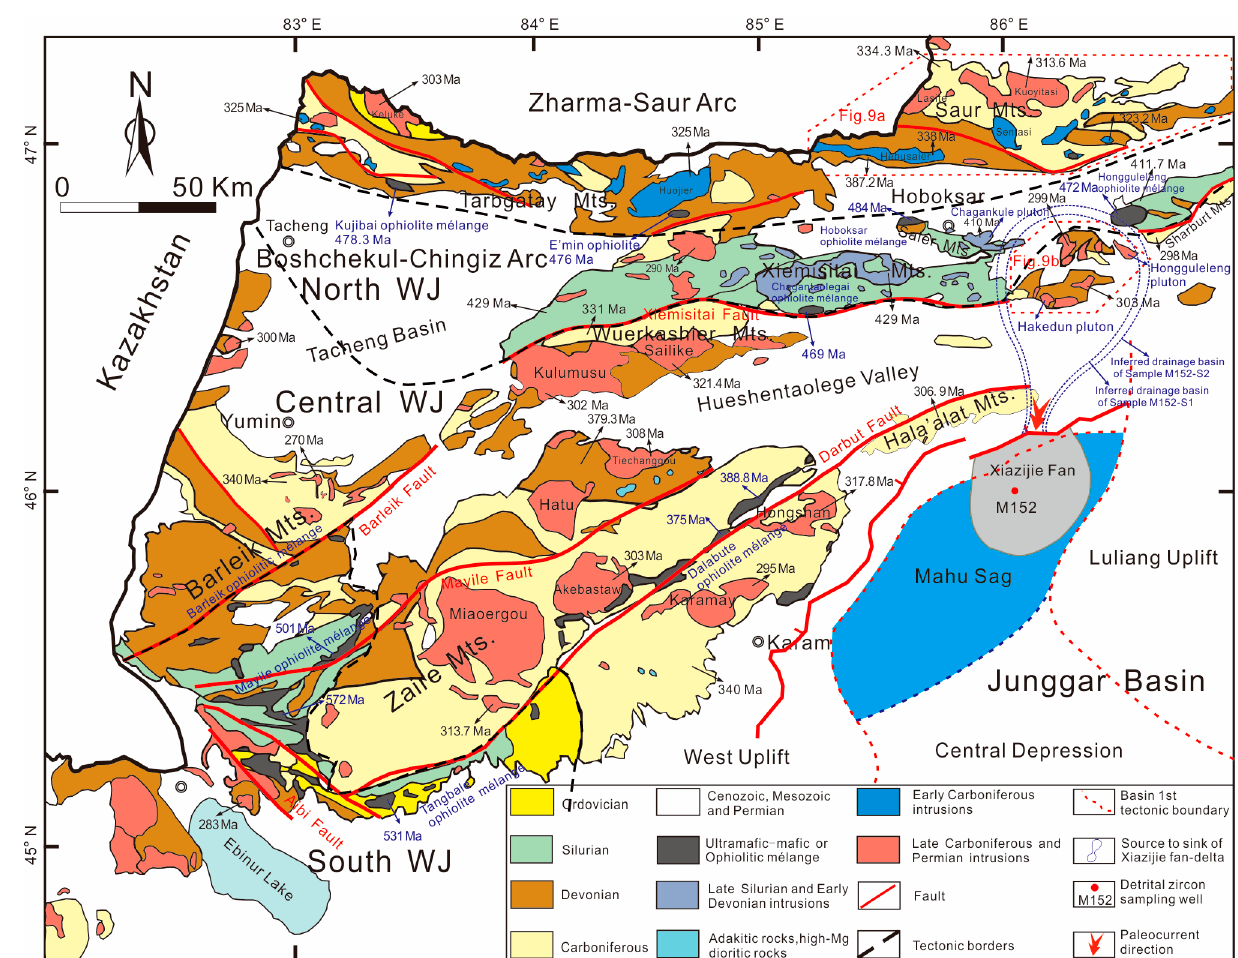
Figure 7. Age distribution map of magmatic rocks in the West Junggar region. Age data for Zharma- Saur arc of the north WJ area are from references [16,19,43,44]; Age data for Boshchekul–Chingiz arc of the north WJ area are from references [21,23,45–48]; age data for central WJ area are from refer- ences [5,16,49–52]; age data for south WJ area are from references [26,53–55].